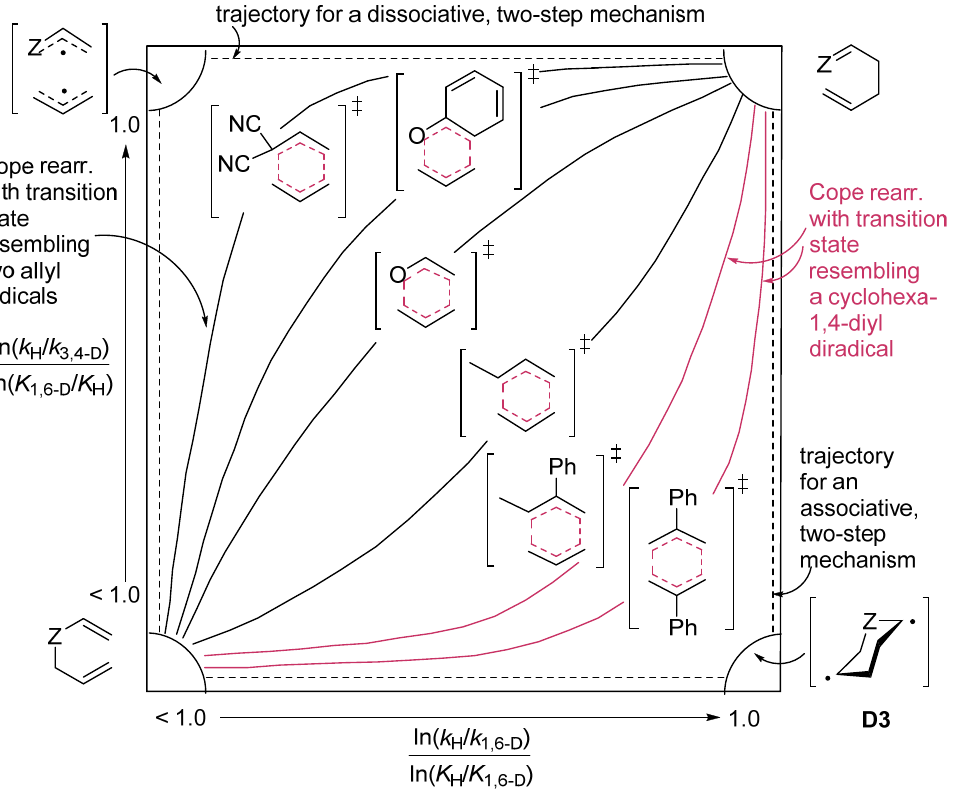
Figure 4. More O’Ferrall–Jencks diagram for Cope and Claisen rearrangements. The horizontal coordinate represents the shortening of the C(1)-C(6) distance; the vertical coordinate represents the lengthening of the σ (C(3)-C(4)) bond; the enthalpy is perpendicular to the plane made by the two former coordinates. The position of the transition states (‡) in this diagram are deduced according to Gajewski from the comparison of kinetic and equilibrium deuterium isotopic effects.